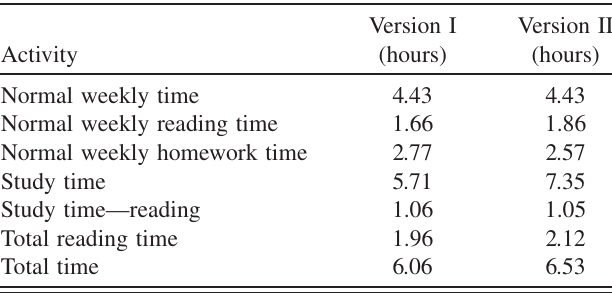
TABLE VII. Average out of class time use.